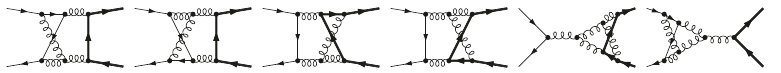
Figure 6 . Two-loop diagrams that, upon interference with the Born amplitude, give rise to van- ishing contributions, due to colour algebra.